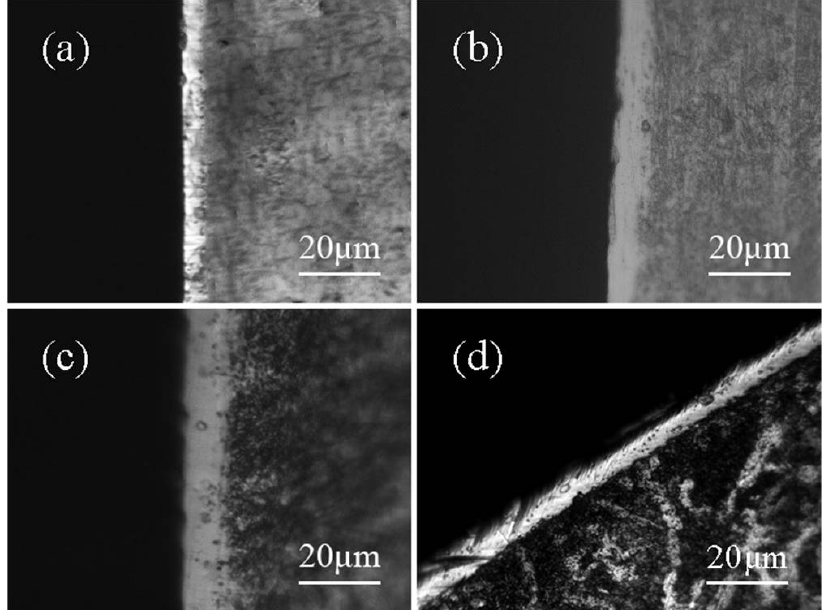
Figure 2. The cross-sectional microstructure of specimens chromized at 960 °C for different time and chromium electroplated. ( a ) 3 h; ( b ) 4.5 h; ( c ) 6 h; ( d ) chromium electroplated.